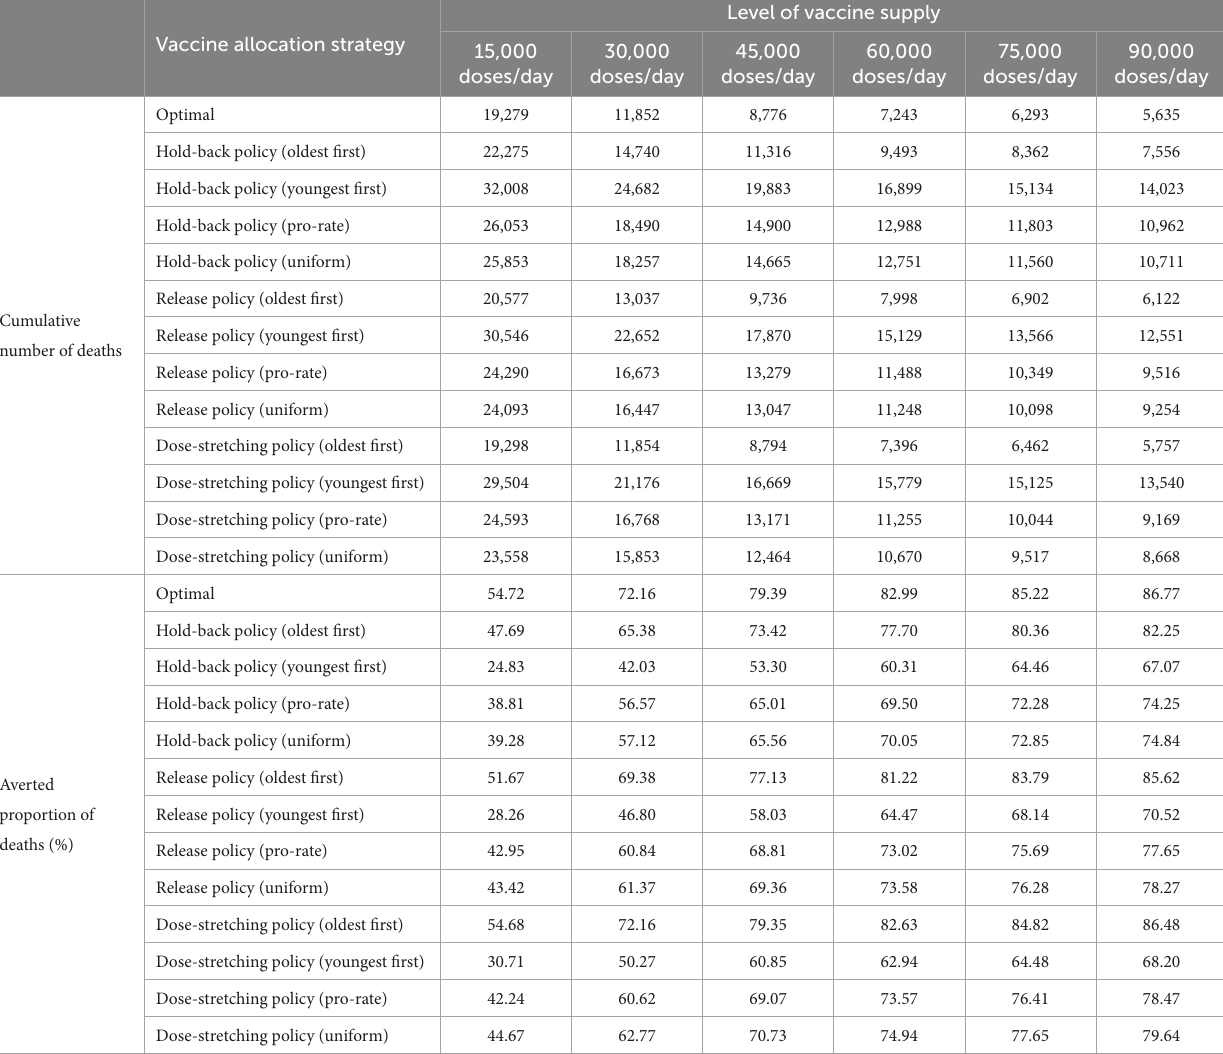
TABLE 2 Comparison of different vaccine allocation strategies with respect to different levels of vaccine supply.